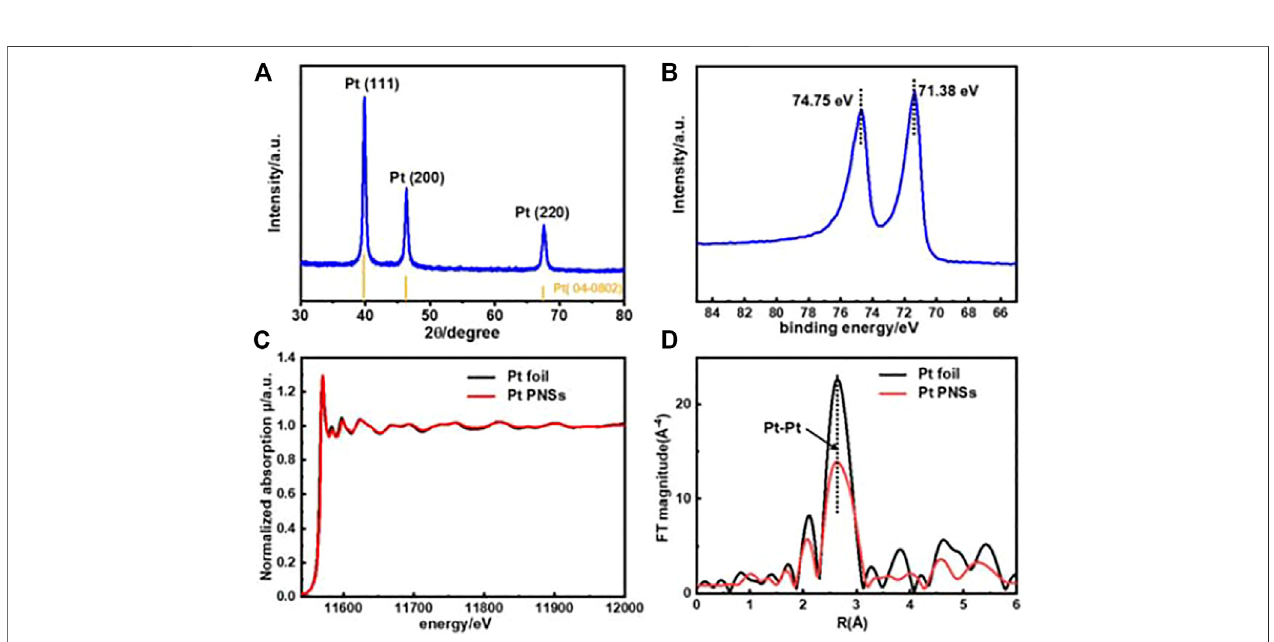
Frontiers in Chemistry |